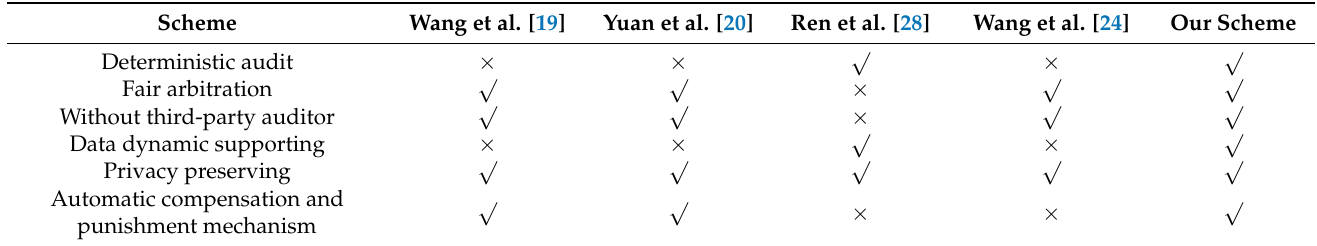
Table 1. Comparison with some related existing data integrity auditing